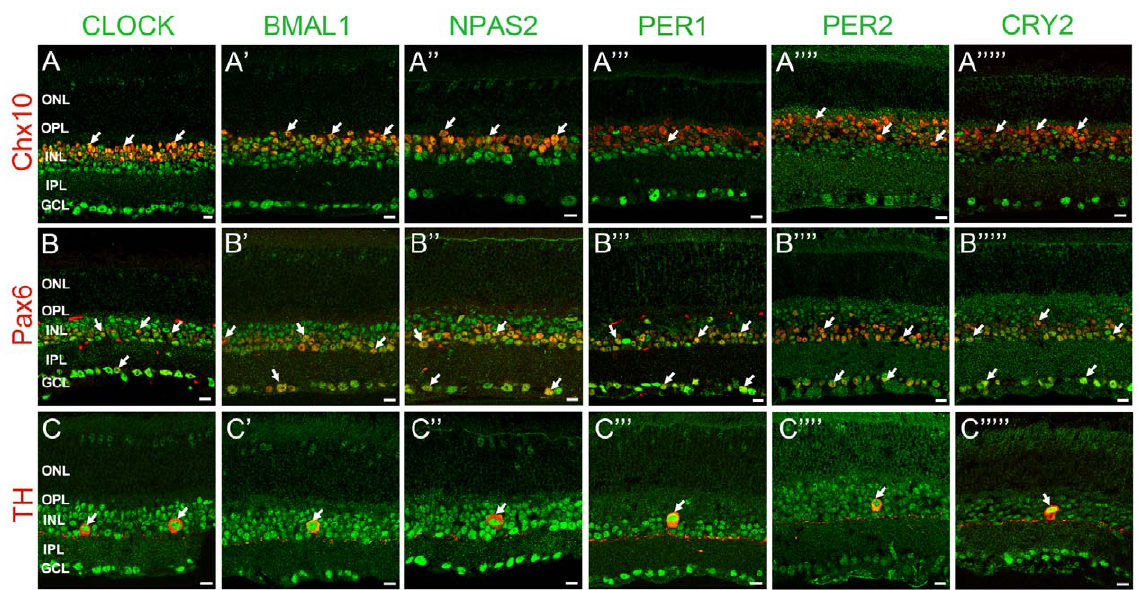
Figure 4. Mammalian core circadian clock protein expression in bipolar, amacrine and ganglion cells of the mouse retina. Typical examples of vertical sections of mouse retinas collected between ZT02 and ZT06 and double labeled for one of the following clock proteins: CLOCK ( A–C ), BMAL1 ( A’–C’ ), NPAS2 ( A’’–C’’ ), PER1 ( A’’’–C’’’ ), PER2 ( A’’’’–C’’’’ ), and CRY2 ( A’’’’’–C’’’’’ ) and one of the following protein markers: Chx10 (bipolar cells; A ), Pax6 (most amacrine cells and ganglion cells; B ), and TH (dopaminergic amacrine cells; C ) (see Table 1 for details about the antibodies). The analysis was restricted to type-1 catecholamine amacrine cells that express high levels of TH. Some double-labeled retinal neurons are shown (arrows). Abbreviations and bar as in Fig. 3.